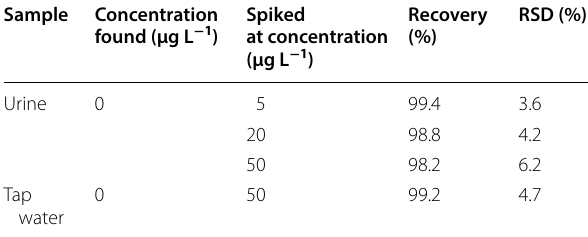
Table 2 Evaluation of carbamazepine in real samples